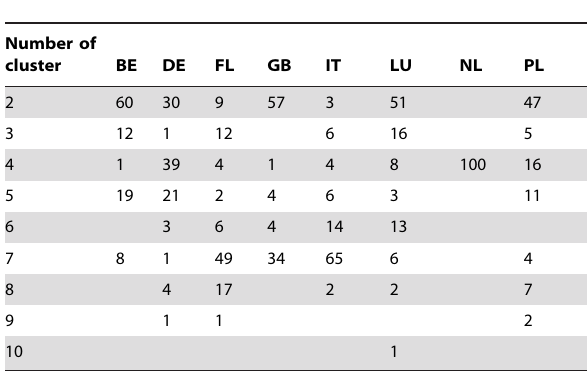
Table 1. Distribution of the optimal number of clusters in 100 runs of cluster analysis with changing ordering of cases based on statistical